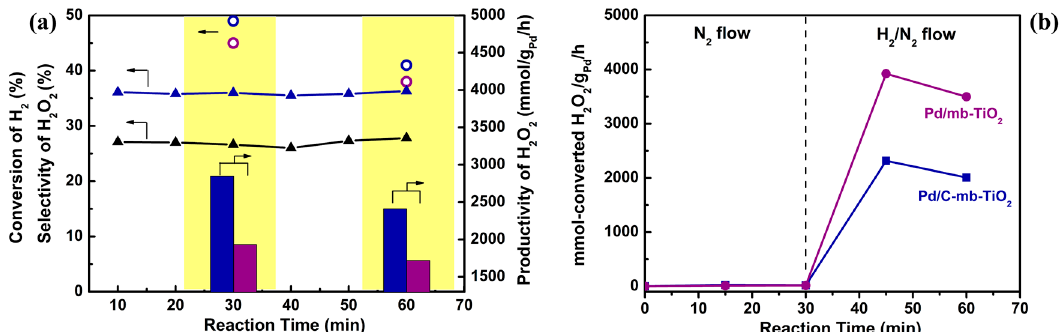
Figure 6. ( a ) H 2 conversion, H 2 O 2 selectivity and productivity, and ( b ) decomposition and hydrogenation of H 2 O 2 over Pd/mb-TiO 2 and Pd/C-mb-TiO 2 . (Blue color indicates Pd/C-mb-TiO 2 , purple color indicates Pd/mb-TiO 2 . Filled triangles: H 2 conversion. Open circles: H 2 O 2 selectivity. Histogram: H 2 O 2 productivity).